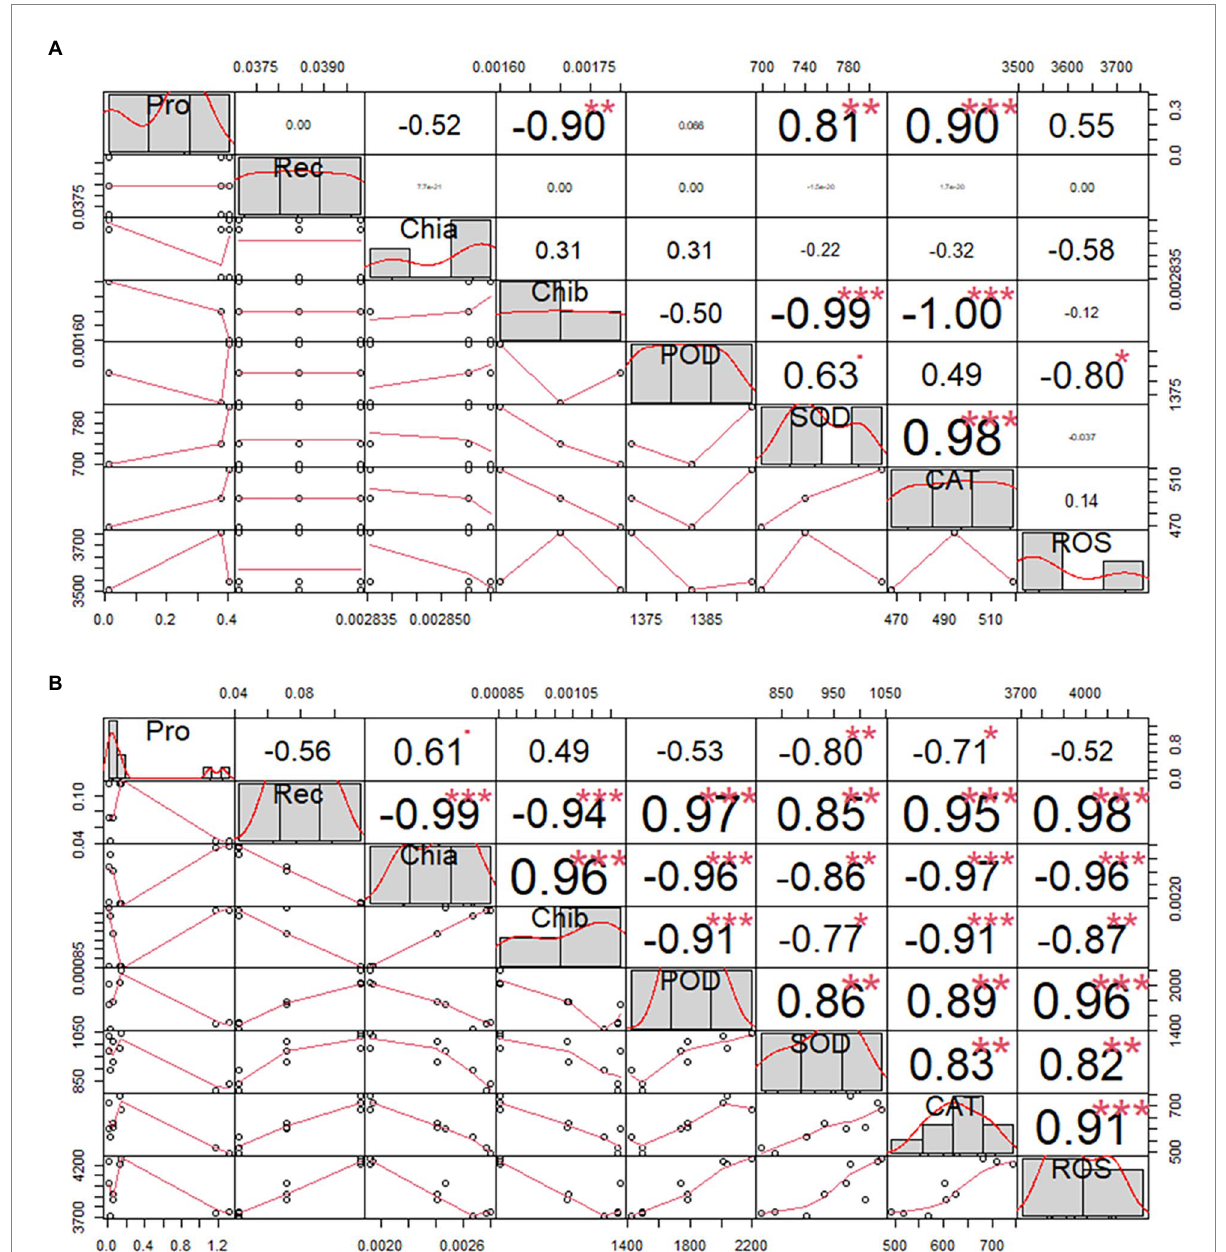
FIGURE 1 Correlation analysis of Helictotrichon virescens phenotypic indicators. Morphological data obtained from samples under (A) the control temperature (25 ° C) and (B) low-temperature stress (0 ° C). * represents p <0.05,** represents p <0.01 and *** represents p